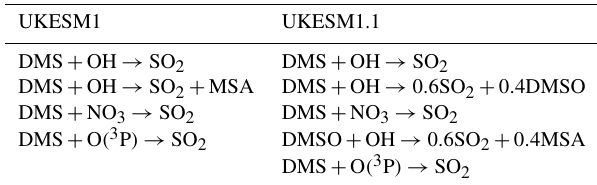
Table 1. Summary of the dimethyl sulfide (DMS) chemical reac- tions in UKESM1 and